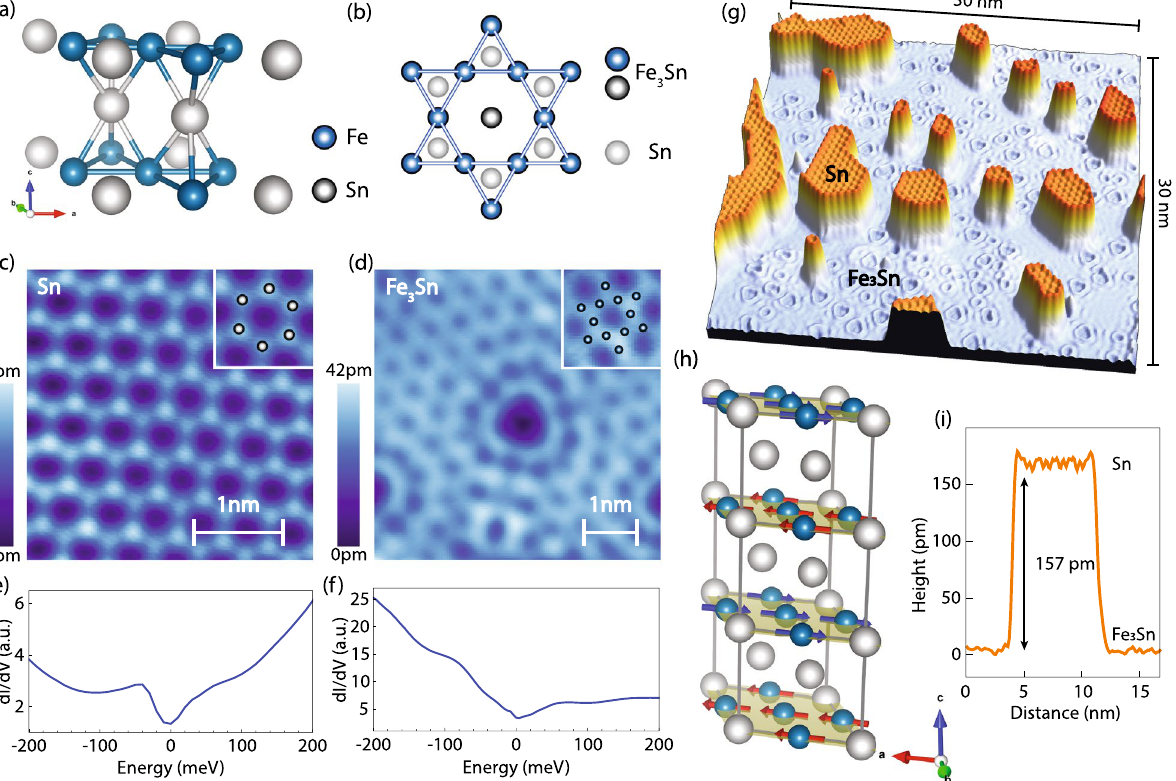
Figure 1. FeSn crystal structure and different surface terminations. ( a ) A 3D schematic of the FeSn atomic structure. ( b ) The ab -plane schematic of the two possible surface terminations: the kagome Fe 3 Sn layer and the hexagonal Sn layer. Blue (gray) spheres in ( a , b ) represent Fe (Sn) atoms. ( c , d ) Zoomed-in STM topographs of ( c ) the Sn surface termination and ( d ) the Fe 3 Sn surface termination. Insets in ( c , d ) show the arrangement of surface atoms on top of the topograph. ( e , f ) Average dI/dV spectra acquired on ( e ) the Sn surface and ( f ) the Fe 3 Sn surface shown in ( c , d ). ( g ) An STM topograph showing Sn islands (upper layer) on top of the Fe 3 Sn surface (lower layer). ( h ) A 3D model showing the layered antiferromagnetic structure of FeSn. Red and blue arrows represent spins that are polarized in the ab -plane in opposite directions. ( i ) A linecut across a small Sn island, showing the apparent Sn-Fe 3 Sn step height of 157 pm, which is a bit smaller compared to the expected height of 222 pm. STM setup condition: ( c ) I set = 600 pA, V sample = 100 mV; ( d ) I set = 800 pA, V sample = − 60 mV; ( e